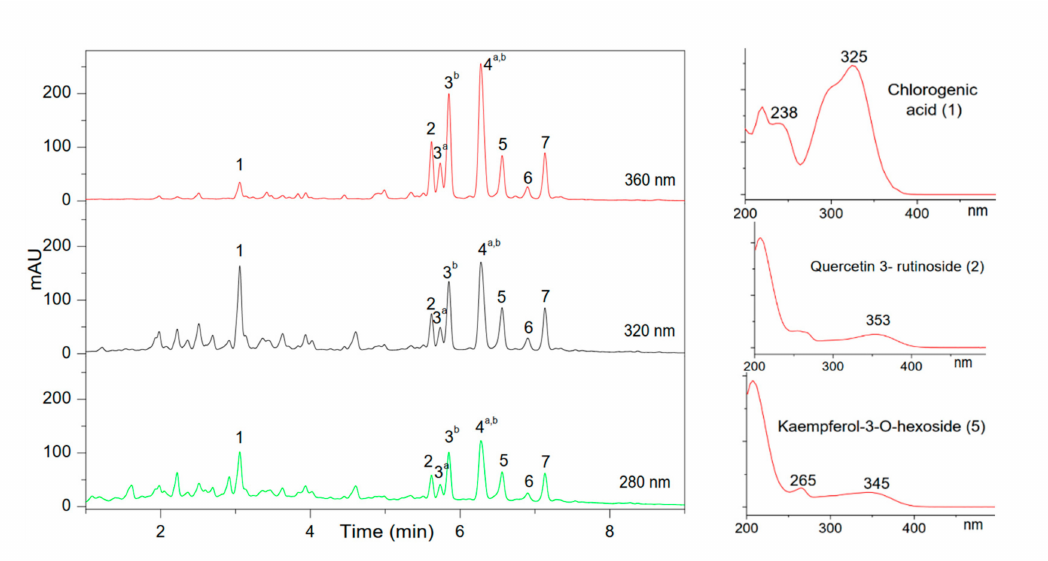
Figure 3. UHPLC profiles of BC extracts issued from infusion Bodum ® extraction mode for ‘fine’ ground BC material monitored at 280, 320, and 360 nm. Typical UV spectra of the main compounds are given on the right. UV spectrum of Chlorogenic acid represents hydrocinnamic acid derivatives, UV spectrum of Quercetin 3- rutinoside (2) represents Quervetin 3-O-galactoside (3 a ), Quercetin 3-O-glucoside (3 b ), and Quercetin-3-6-malonyl-glucoside (4 a ), UV spectrum of Kaempferol-3-O-hexoside (5) represents Kaempferol-3-O-rutinoside (4 b ), Kaempferol-malonylglucoside (6), and Kaempferol-malonylglucoside isomer (7). See Table 4 for peak ID. Lot number: 55870. See Figure S4 for UHPLC profiles of other